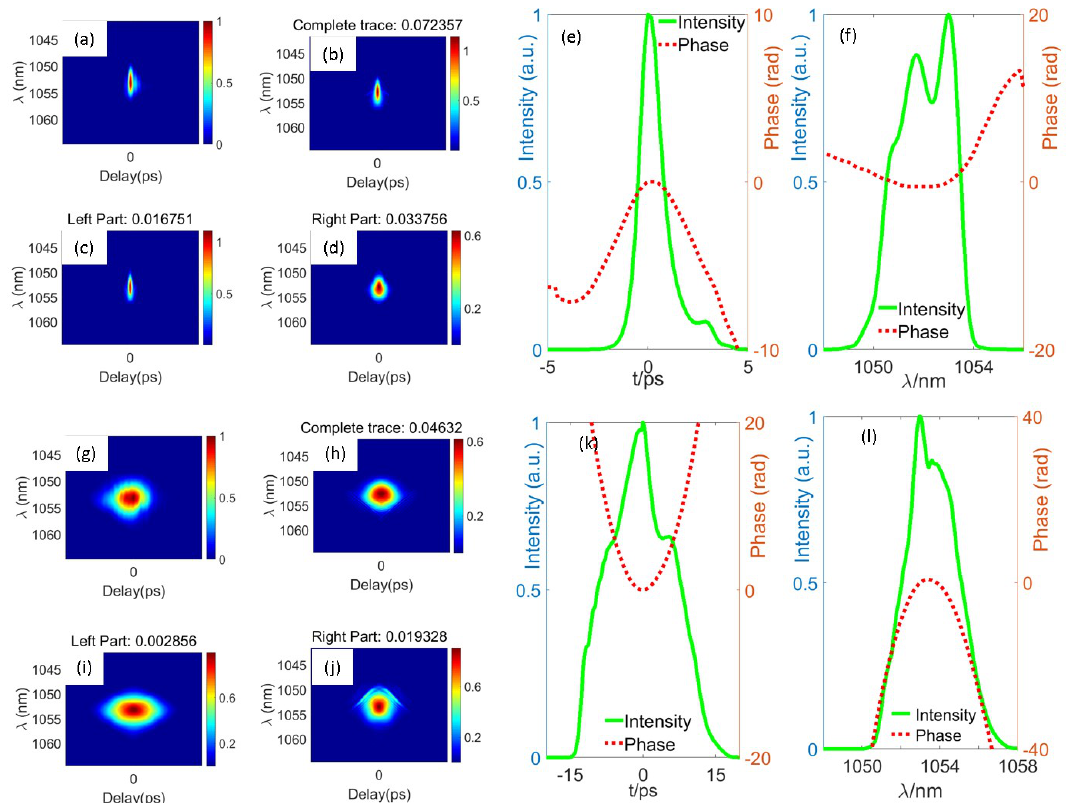
Figure 8. Experimental pulse reconstructions of two shots on PW laser system with second harmonic generation (SHG) FROG. The reconstructed results are divided into second groups. ( a , g ) present the recorded SHG − FROG trace. ( b , h ) present the reconstructed FROG trace using complete trace retrieval algorithm. ( c , i ) show the reconstructed trace using half-trace retrieval algorithm using negative delay range, while ( d , j ) show the same using a positive delay range. The reconstructed errors between measured and reconstructed trace are presented on top of the reconstructed trace. ( e , k ) and ( f , l ) show the reconstructed pulse distribution with the smallest reconstructed error in temporal and spectral